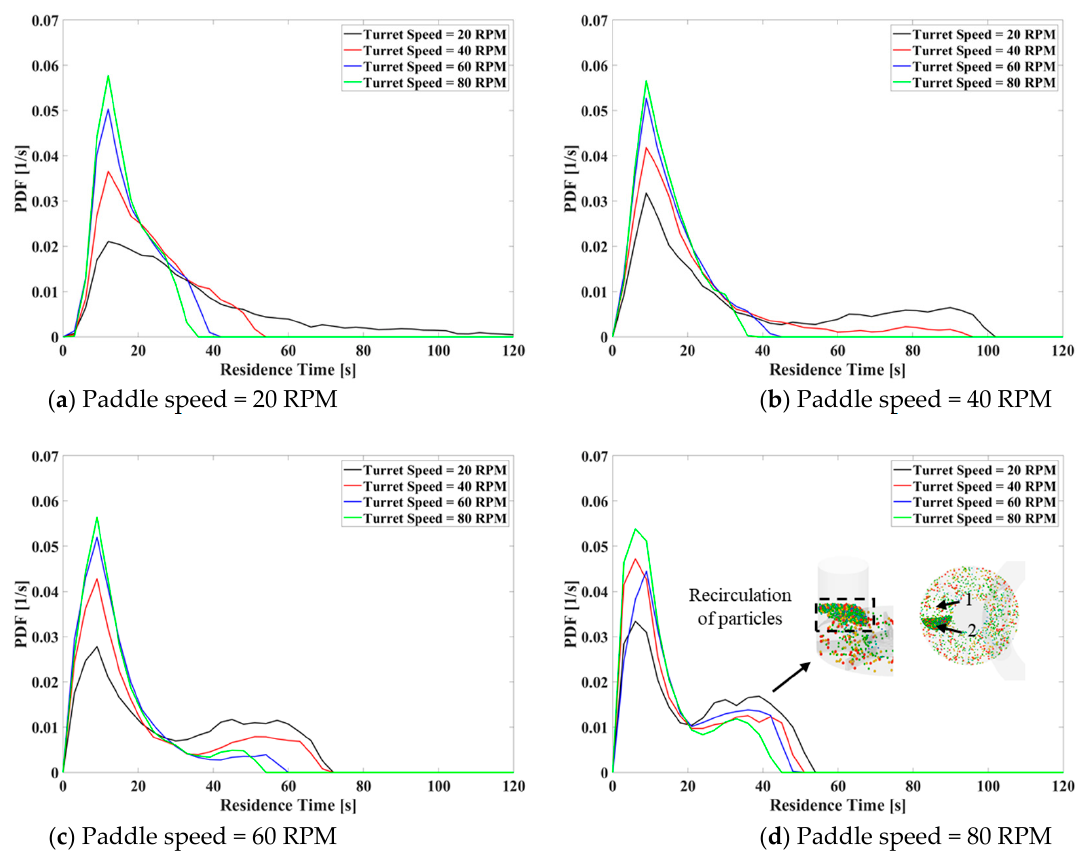
Figure 5. ( a ) Effect of paddle speed and turret speed on residence time distribution: ( a ) paddle speed 20 RPM; ( b ) paddle speed 40 RPM; ( c ) paddle speed 60 RPM; ( d ) paddle speed 80 RPM, at four turret speeds of 20 RPM, 40 RPM, 60 RPM, and 80 RPM. Image d also shows snapshots from the DEM simulation showing the recirculation phenomenon and stagnant particles.